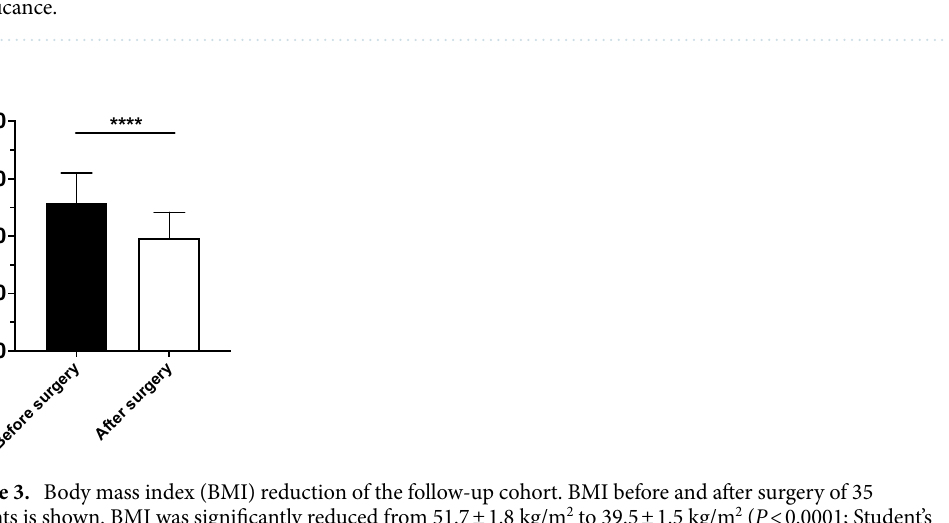
Figure 2. Difference (∆) of the age-adjusted (aa) telomere length (TL) before bariatric surgery. Depicted is the ΔaaTL correlation with the patients’ body mass index (BMI) before surgery. Positive values of the ΔaaTL represent an increase of the TL after surgery in lymphocytes ( A ) (blue dots; n = 35) and granulocytes ( B ) (yellow dots; n = 32). The regression line for lymphocytes ( A ) ( P = 0.28) and granulocytes ( B ) ( P = 0.26) shows no significance.